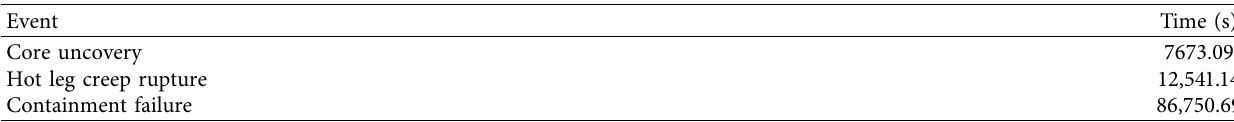
Table 18: Time of key events with PAR activation.